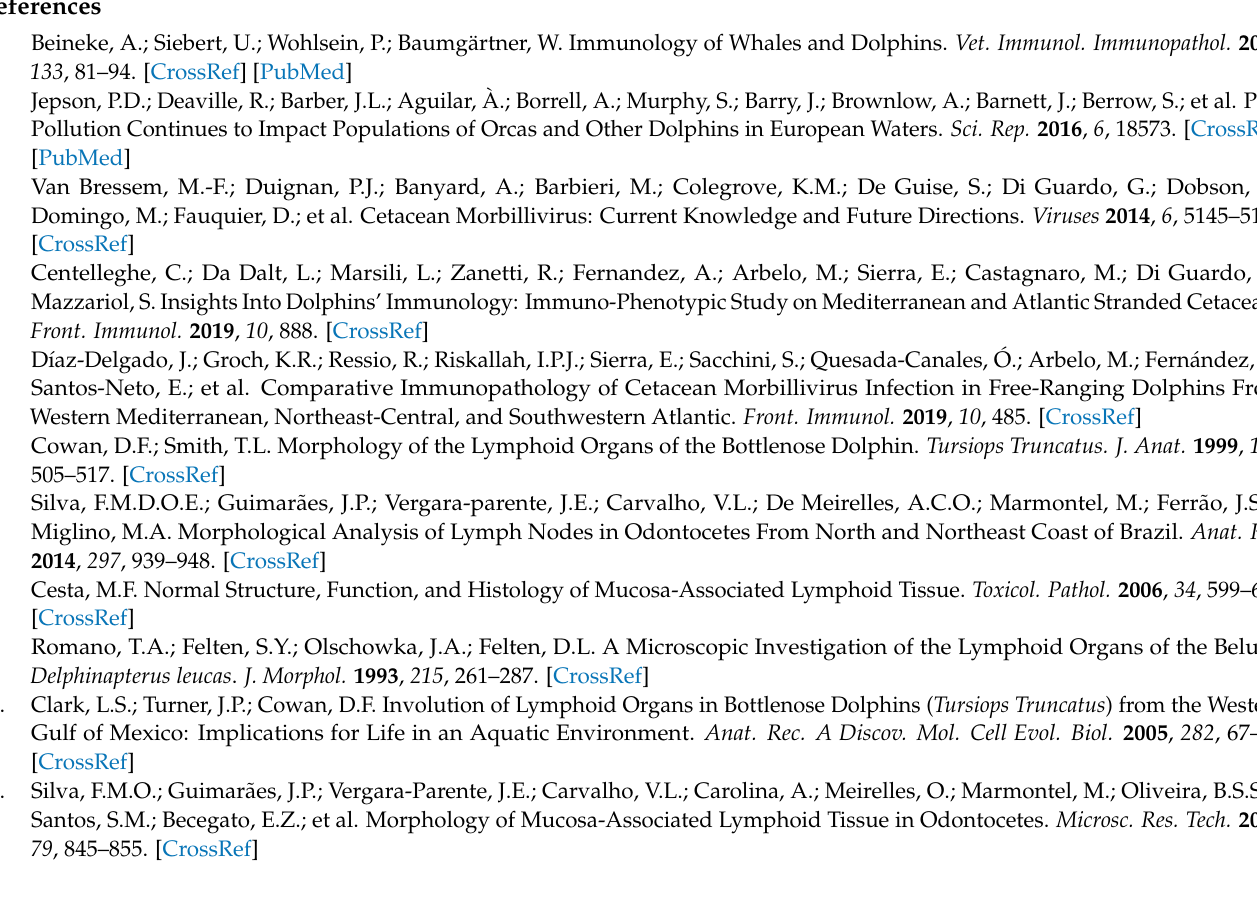
Figure A3. A histological image (HE staining) of a transverse section through the external ear canal of a long-finned pilot whale (441) at about 5 cm beneath the skin. The ear canal contains inflammatory cells and epithelial cells, while there is the circummeatal presence of mixed inflammatory cells. Scale bar = 100 µm.